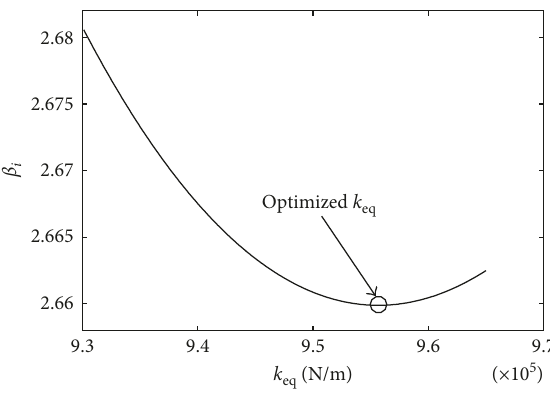
Figure 4: Optimization process of k